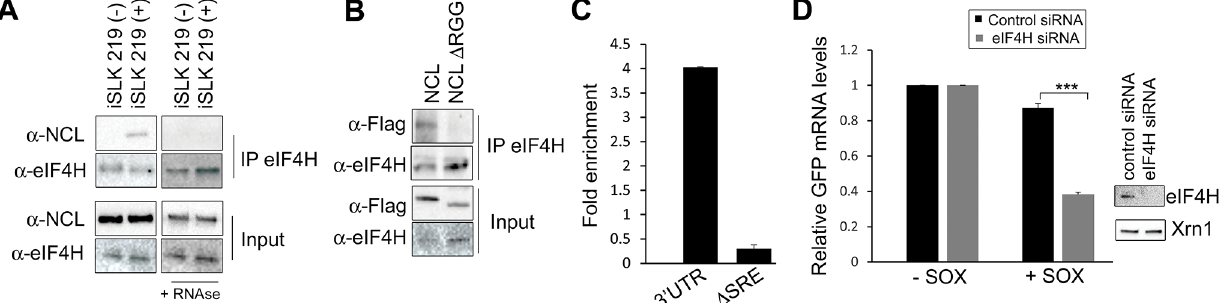
Fig 6. IL-6 escape is potentiated by an NCL-eIF4H interaction. (A) Lysates of latently infected (-) or DOX-reactivated (+) KSHV-positive iSLK.219 cells were subjected to IP with an anti-eIF4H antibody, then Western blotted (WB) for NCL or eIF4H. Where indicated, lysates were treated with RNAseA and RNAse T1. (B) 293T cells were transfected with the indicated FLAG-tagged NCL expression construct, subjected to IP with anti-eIF4H antibody, and Western blotted for FLAG-tagged proteins and eIF4H. (C) 293T cells were transfected with the indicated GFP reporter (3 ’ UTR or Δ SRE) and FLAG-tagged NCL Δ RGG, cross linked in 1% formaldehyde for 10 min, and lysed. Lysates were subjected to RNA immunoprecipitation (RIP) with anti-flag (or mock IP with IgG) and the co-purifying mRNA was quantified by RT-qPCR. Bars represent the fold enrichment over mock IP. (D) 293T cells were treated the indicated control or eIF4H-targeting siRNA. Cells were co-transfected 48h later with plasmids expressing the GFP IL-6 3 ’ UTR reporter construct in the presence or absence of SOX. GFP mRNA levels were quantified by RT-qPCR ( left panel ), and eIF4H knockdown efficiency was monitored by Western blot ( right panels ). Xrn1 was included as a loading